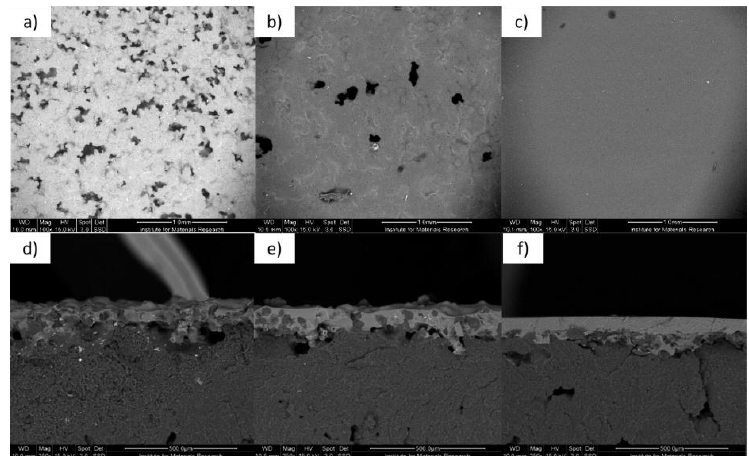
Figure 4. ( a – c ) Scanning electron microscope surface images of a 10, 20, and 30-layer PVDF coating